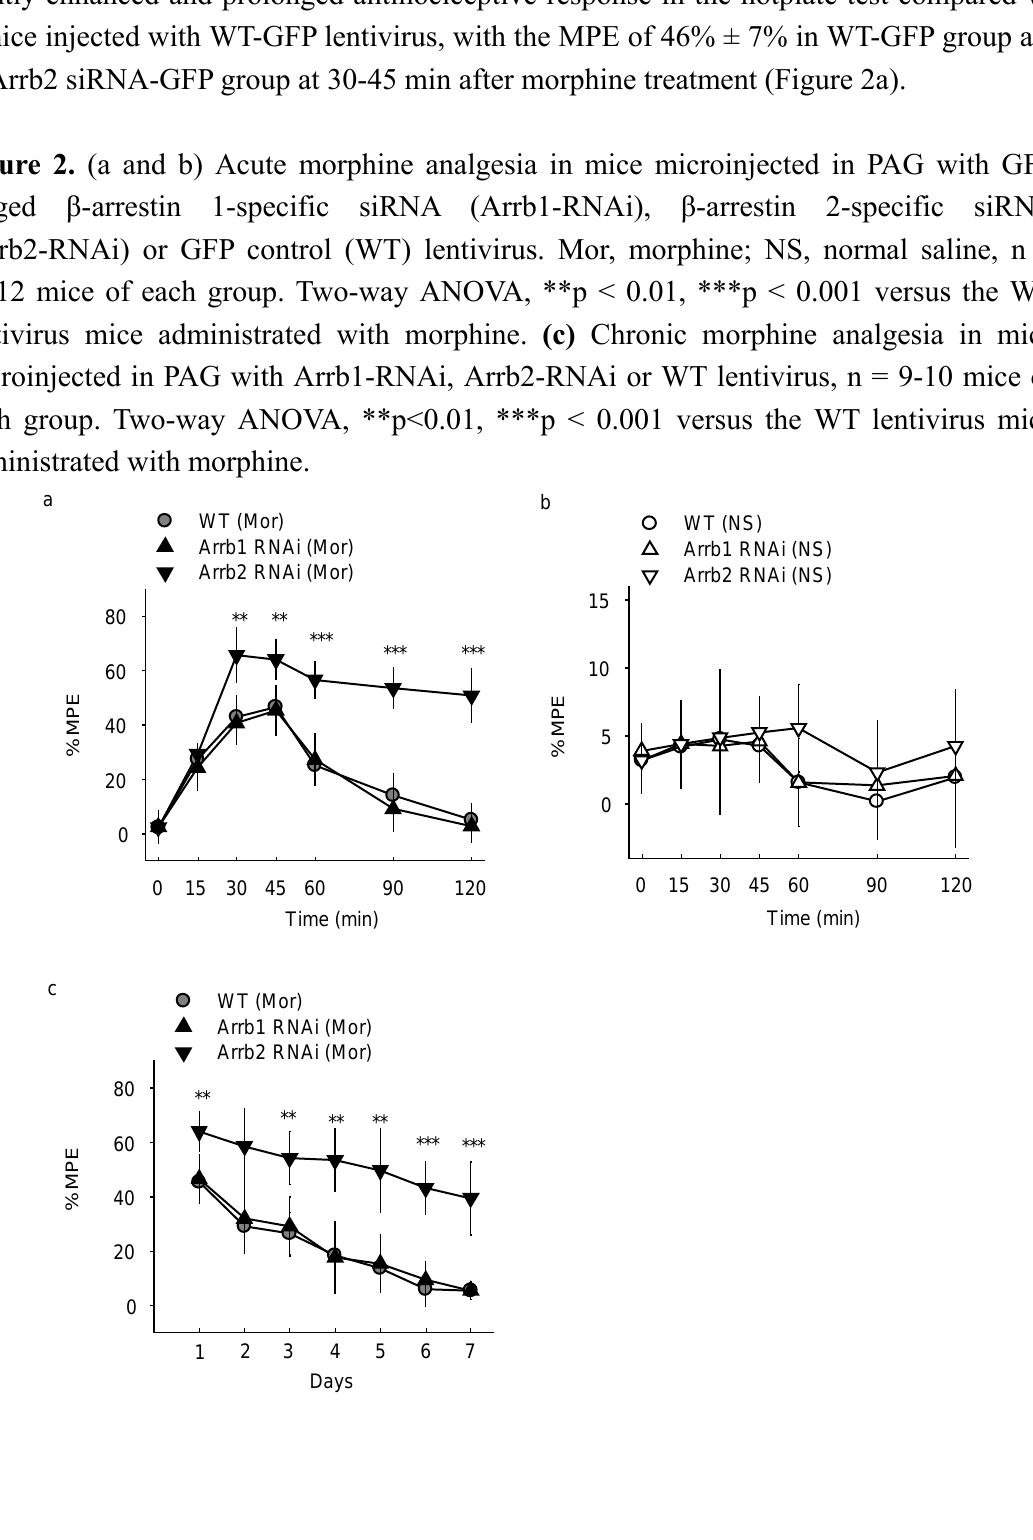
β -arrestin 1-specific siRNA (Arrb1-RNAi), β -arrestin 2-specific